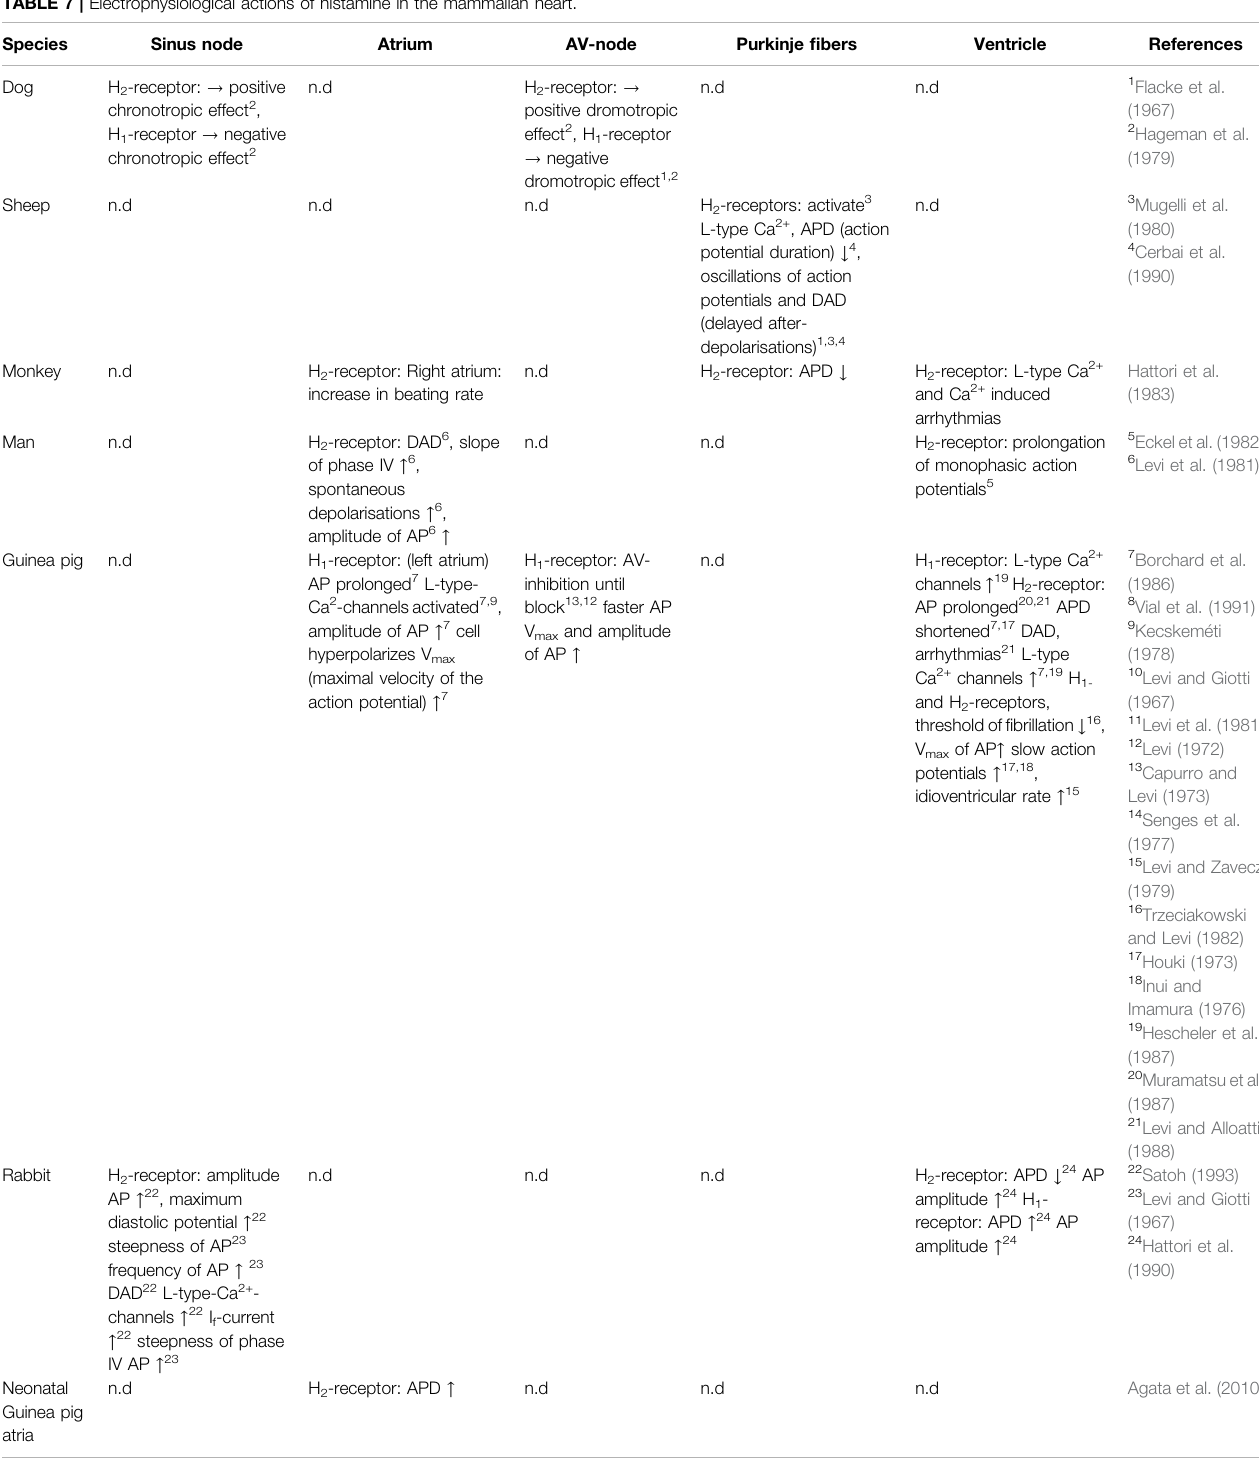
TABLE 7 | Electrophysiological actions of histamine in the mammalian heart.